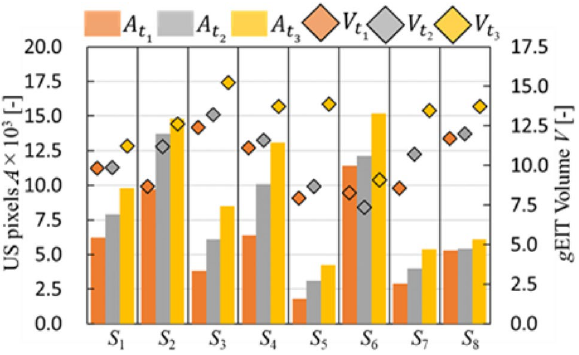
σ distribution. (cid:31) (cid:30)